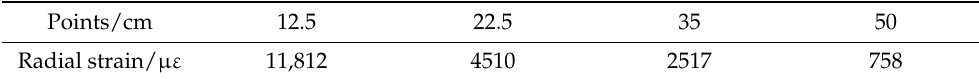
Table 7. Peak strain of each measuring